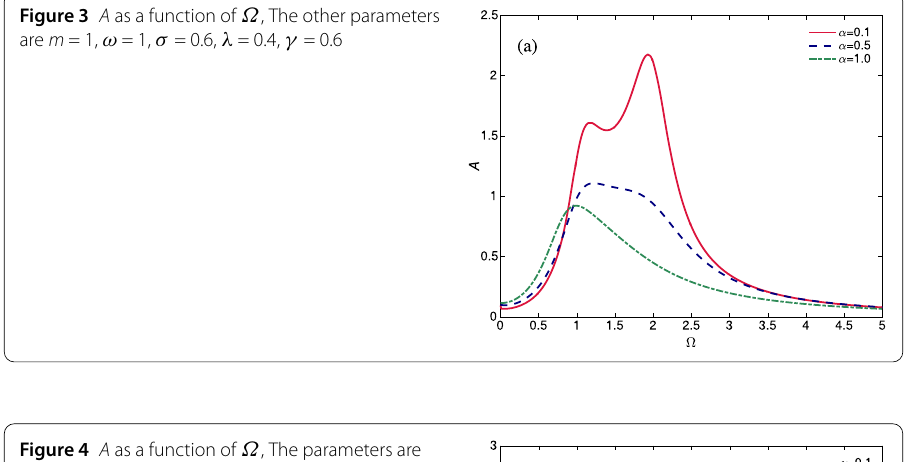
Figure 4 A as a function of Ω , The parameters are m = 1, ω = 1, σ = 0.6, λ = 0.4, α = 0.6